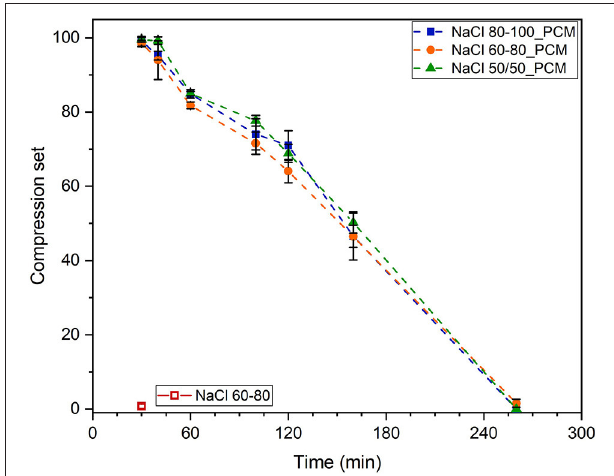
FIGURE 6 | Compression set (CS) values of TES-EPDM foams stored at 0 ◦ C for 22h and tested at room temperature as function of time after recovery between 30 and